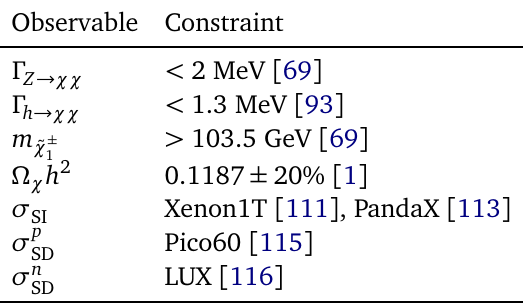
Table 1: Overview of the constraints on the dark matter